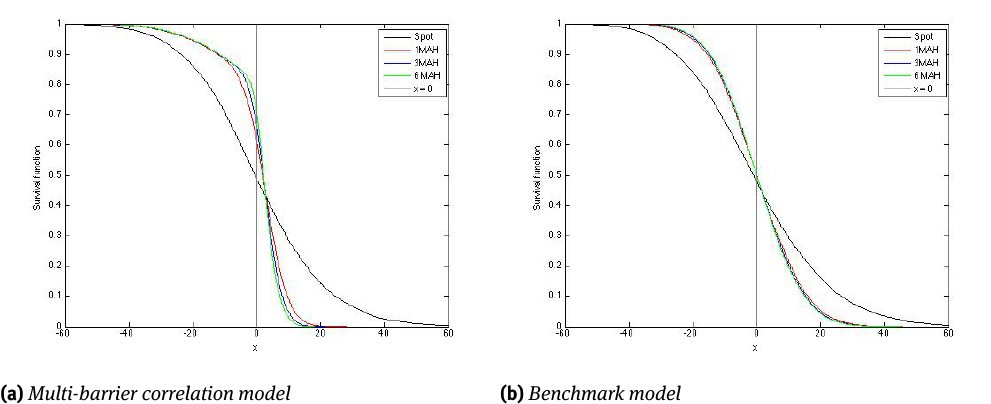
Figure 10: Empirical survival function of the difference between the price of electricity and the price of coal at time t = 365 days estimated with 10000 simulations with a time step of 1 24 days for different products (Spot, 1MAH, 3MAH, 6MAH) in the multi- barrier correlation model and in the benchmark